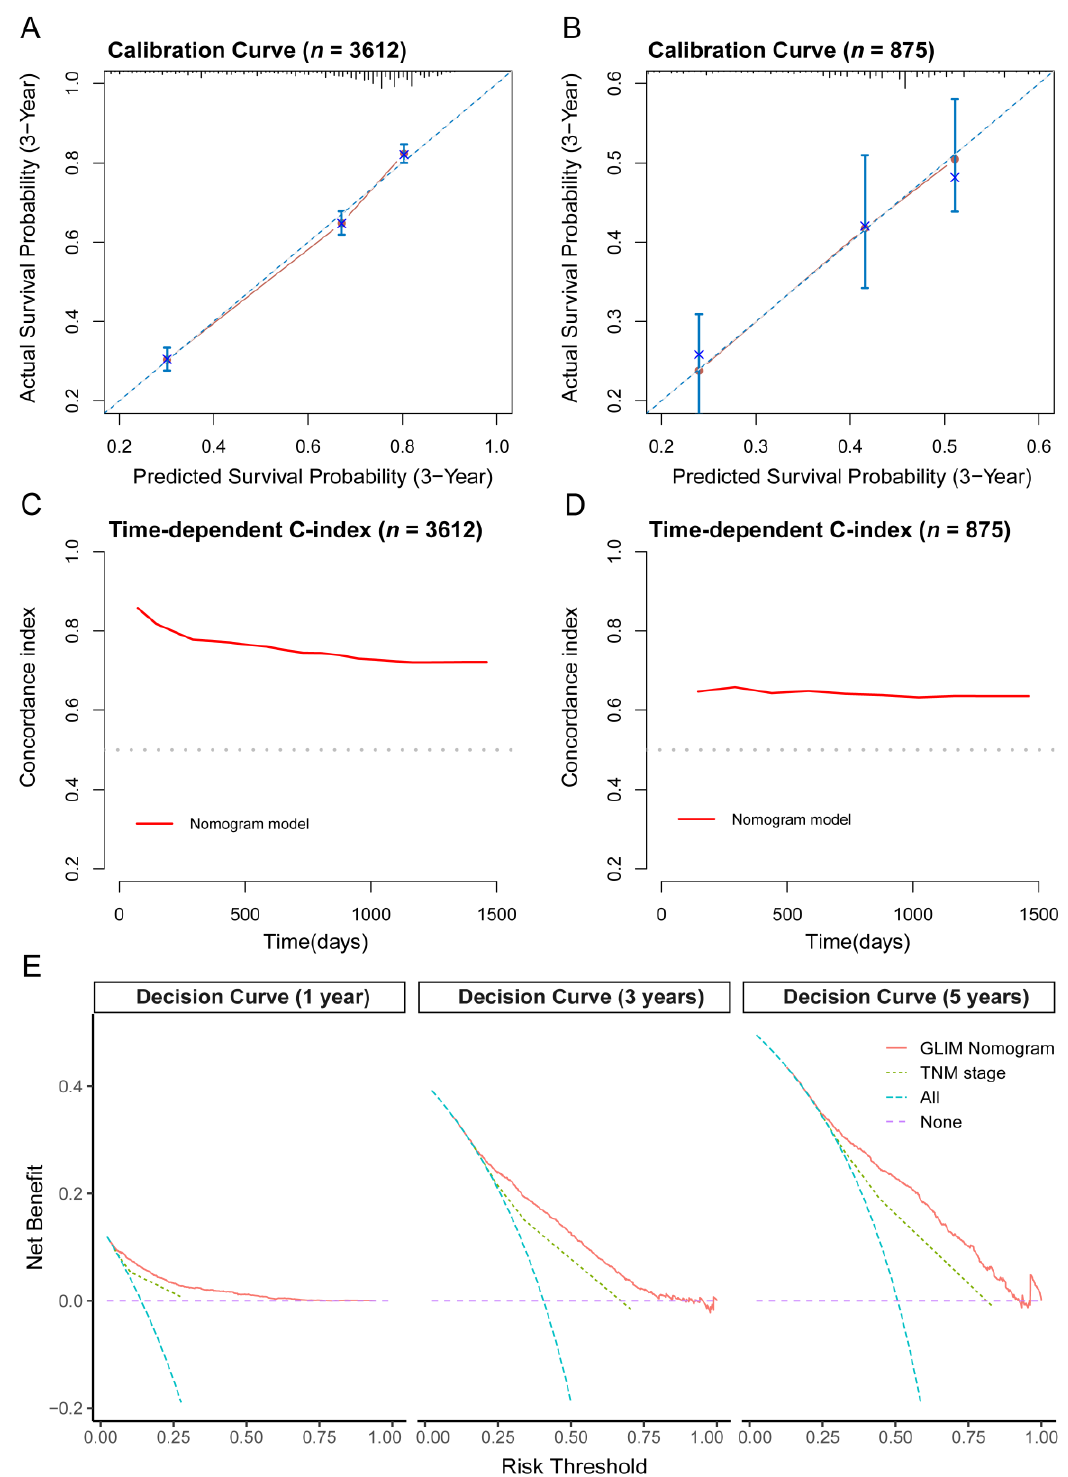
Figure 4. Validation of the nomogram for overall survival prediction in CRC patients. ( A ) The calibration curve for predicting patient survival at 3 years in the development cohort and ( B ) validation cohort. ( C ) Time-dependent C-index of the nomogram in the development cohort and ( D ) validation cohort. ( E ) The decision-curve analysis of the GLIM nomogram and TNM stage at 1, 3, and 5 years (in the development cohort). C-index, Concordance index; GLIM, the Global Leadership Initiative on Malnutrition.